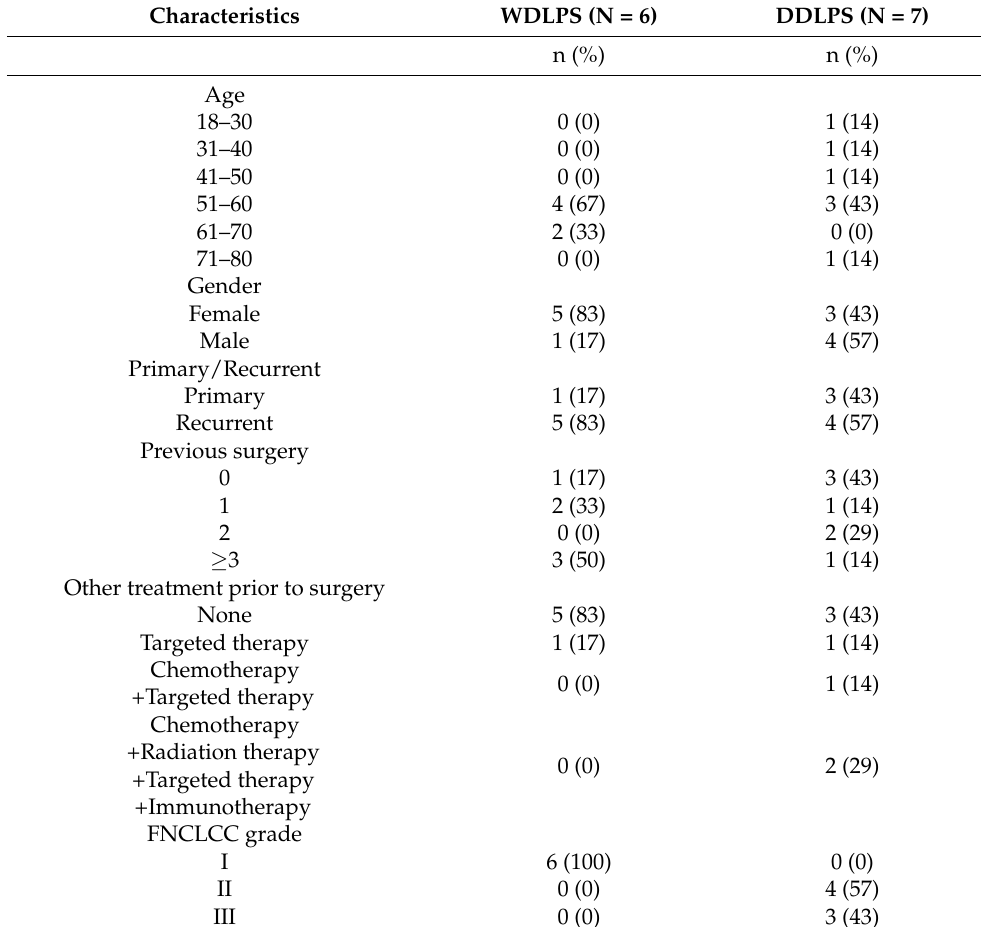
Table 1. Clinicopathological characteristics of liposarcoma patients.